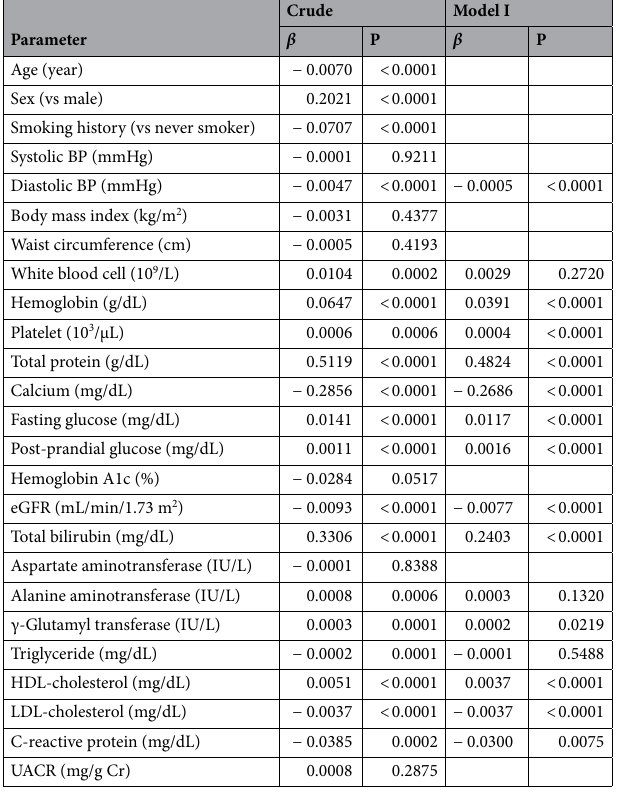
Table 2. Multiple linear regression analysis for serum albumin. Model I: adjusted for age, sex, and smoking history.